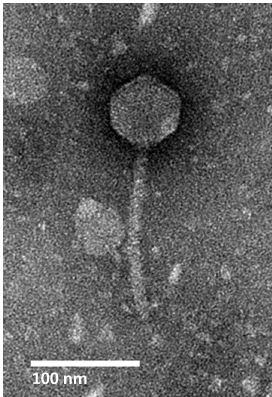
Figure 1. Transmission electron micrograph of AXL3. High titer lysate was stained with 4% uranyl acetate on a copper grid and viewed at 110,000× magnification with a transmission electron microscope. Measurements of 10 phage particles have an average capsid length and width of 64 nm and 63 nm, and tail length of 145 nm.